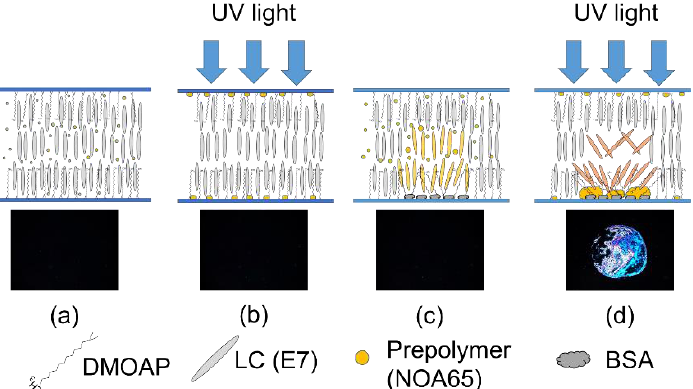
Figure 2. The working principle of the biosensing platform based on the LC–photopolymer composite. ( a ) Before UV exposure and in the absence of biomolecules, the LC molecules are vertically aligned in the presence of a minute concentration of NOA65, resulting in a completely dark optical texture. ( b ) After UV exposure, polymer gravels of NOA65 form on the substrates but are still unable to weaken the vertical anchoring of DMOAP. ( c ) In the presence of immobilized biomolecules at relatively low concentrations, the optical texture is still dark, which implies that the tilt angle of the LC molecules was not significantly affected. ( d ) To achieve signal amplification, the mixture of LC and NOA65 was irradiated with UV to induce the polymerization of NOA65, which leads to significant change in the tilt angle of LC molecules, giving rise to enhanced brightness in the optical texture.